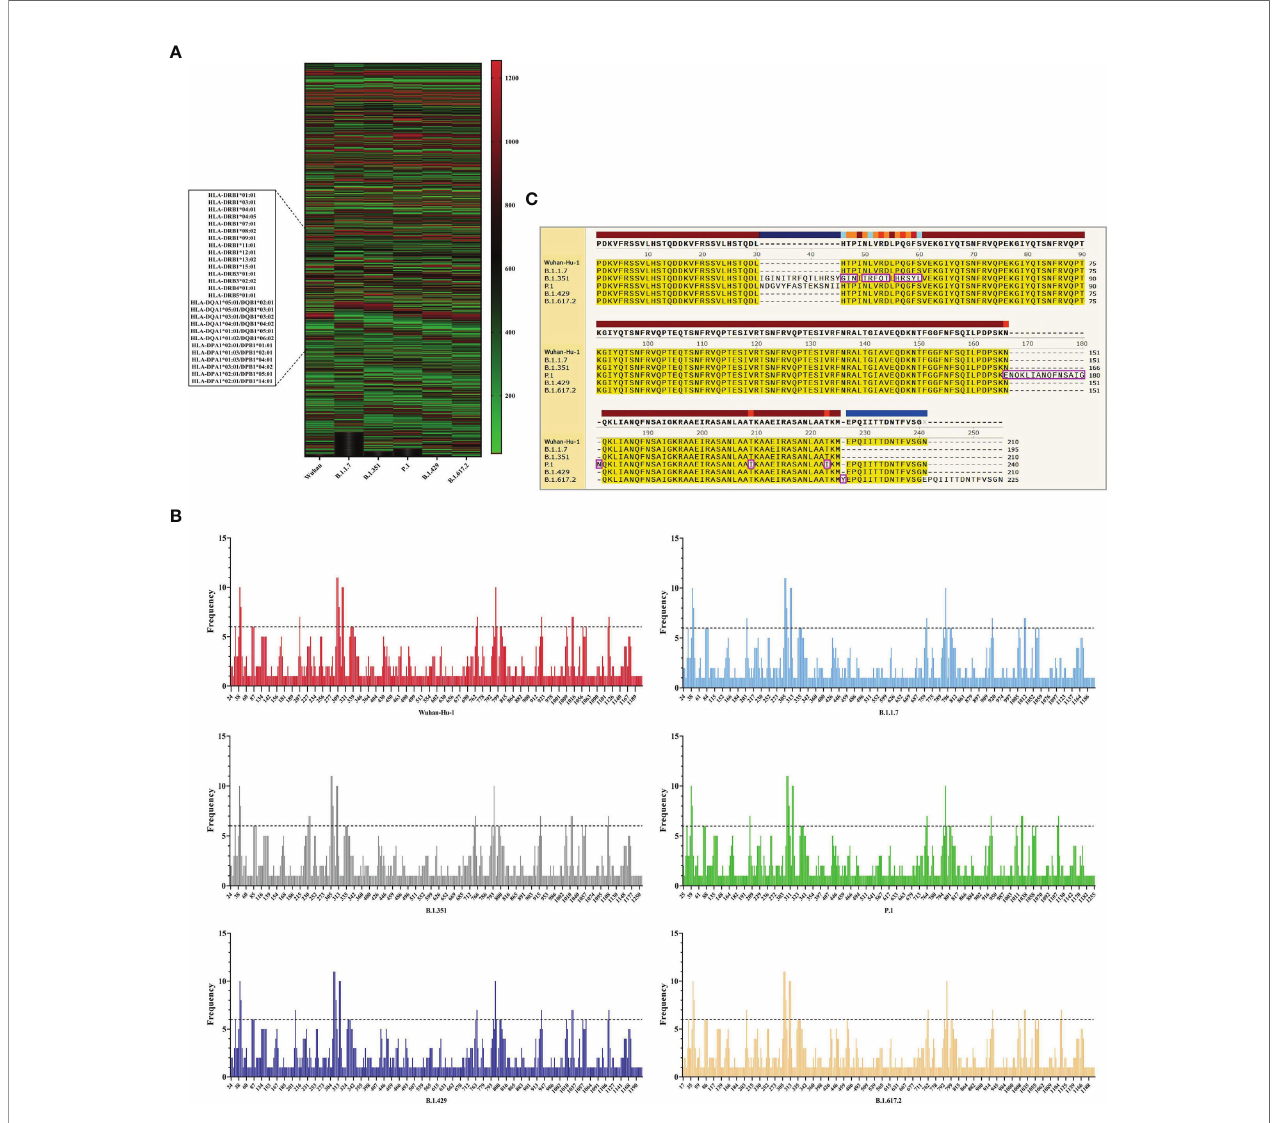
FIGURE 5 | The identi fi cation of HTL epitopes. (A) After identifying the 27 kinds of HLA-II alleles, all the HTLEs of the S protein in the 6 SARS-CoV-2 strains were shown here. The abscissa represents the six virus strains and the ordinate represents the position of the beginning of the epitope peptide. (B) The abscissa represented the position of the beginning of the epitope, and the ordinate represented the frequency of the epitope in the 27 alleles. (C) All epitopes of each virus strain were connected in sequence according to the size of the starting position, and the epitopes that had undergone mutation were in the “ pink ” box. Through sequence alignment, all the common and variant epitopes of all strains were used for vaccine